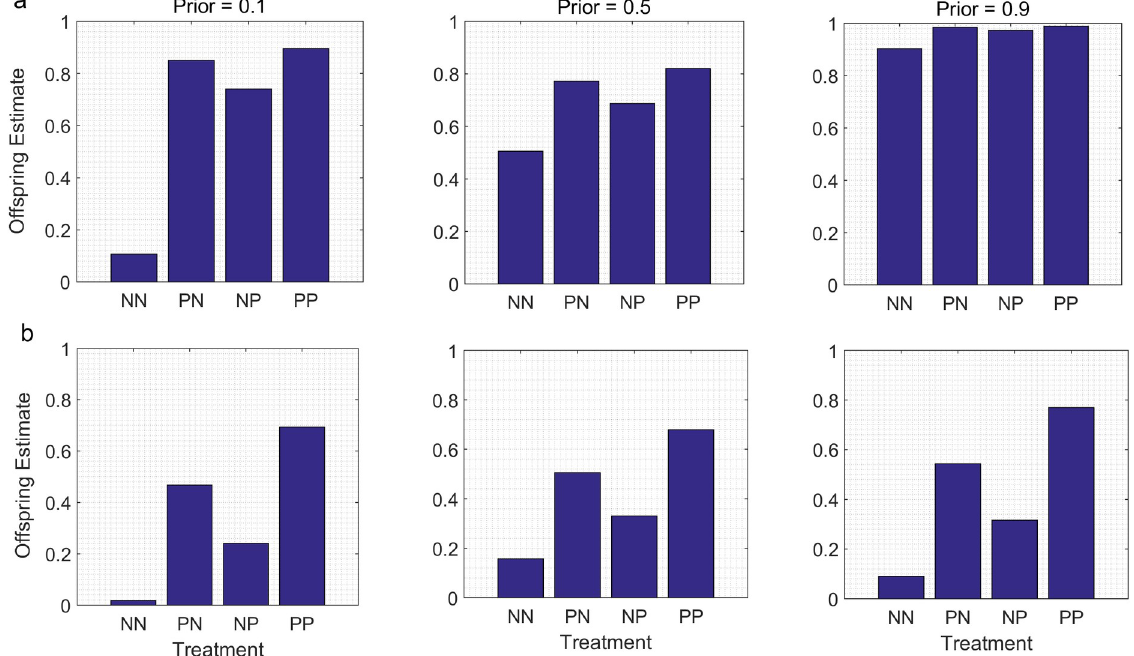
Fig 3. Duration of exposure to the same cues is longer for parents than for offspring. In the P treatment groups, parents are exposed to the presence of cues from predators for time four intervals, but offspring are exposed to cues from predators for only two of the four time intervals (see text). Other variables are the same as in Fig